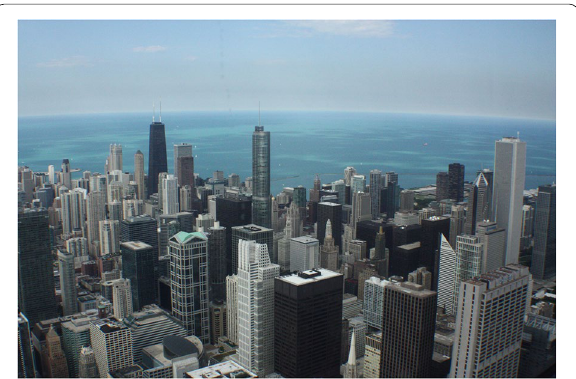
Fig. 7 Chicago’s competitive individualism as seen from the John Hanckock